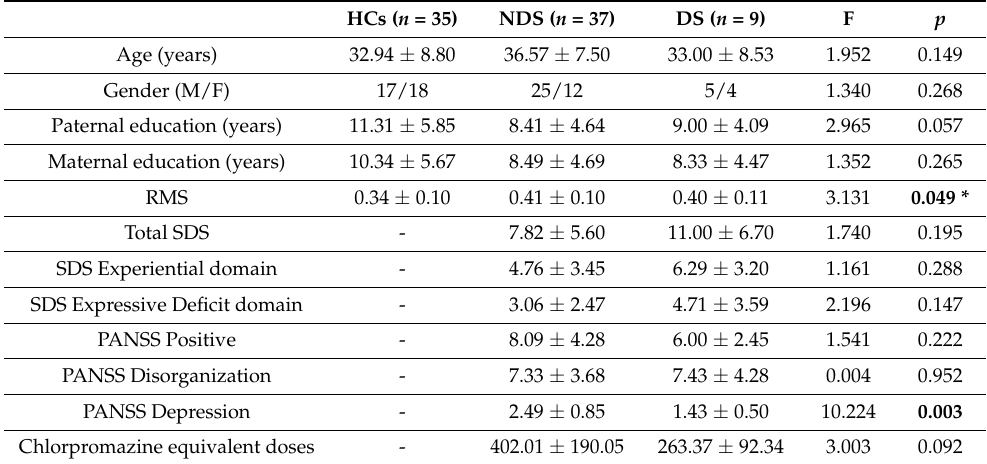
Table 1. Demographic characteristics, RMS and illness-related variables of the study sample (HCs, NDS and DS).